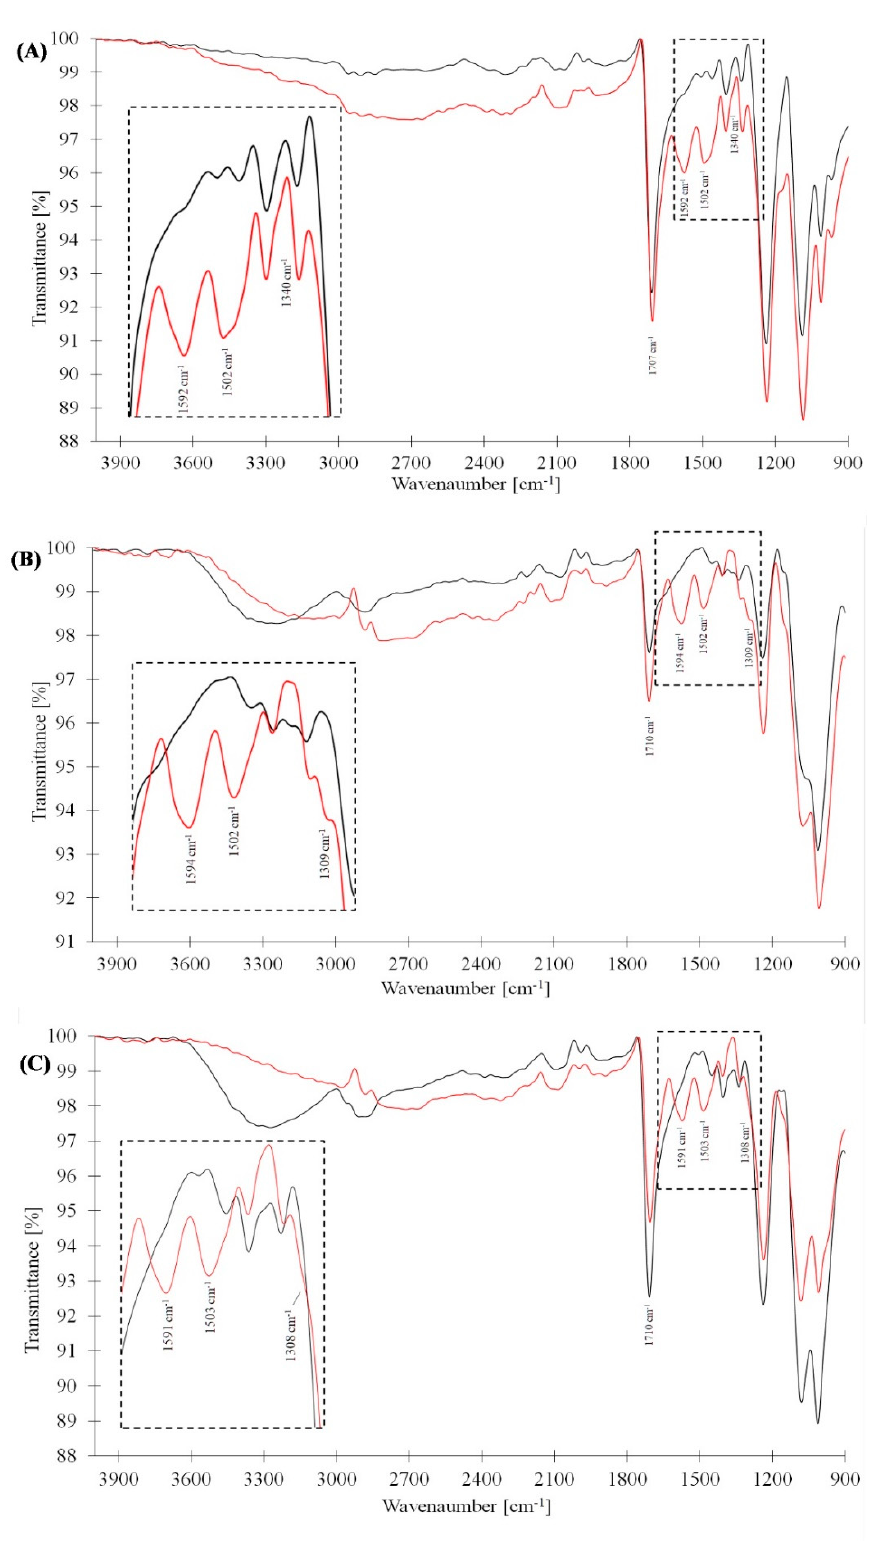
Figure 3. FTIR results of PET fabrics ( A ), viscose ( B ) and 50:50 PET:viscose ( C ). Black line—neat fabrics, and red line—PANI-coated fabrics (171